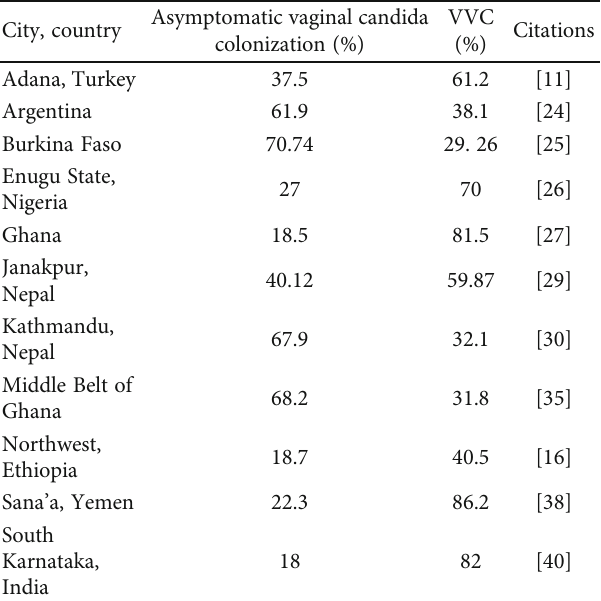
Table 2: The previously reported prevalence of VVC and asymptomatic vaginal candida